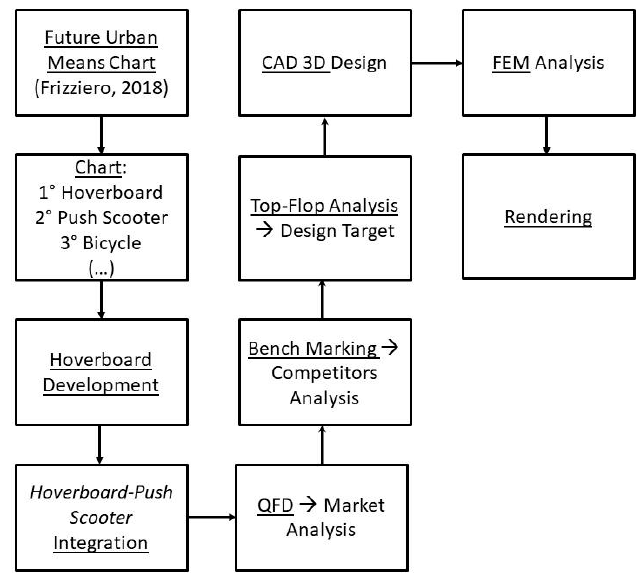
Figure 3. Flow Chart of the Project.